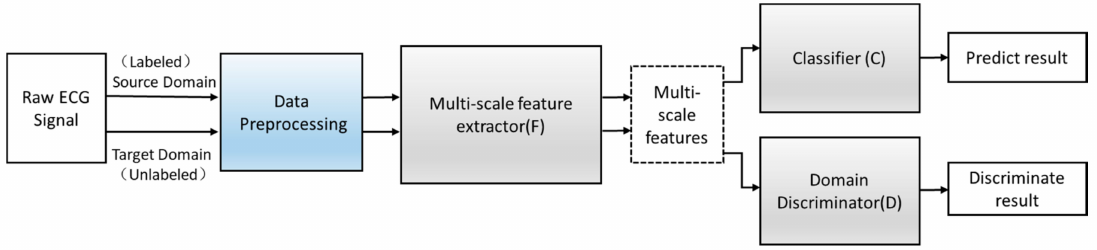
Figure 4. The structure of the adversarial domain adaptation